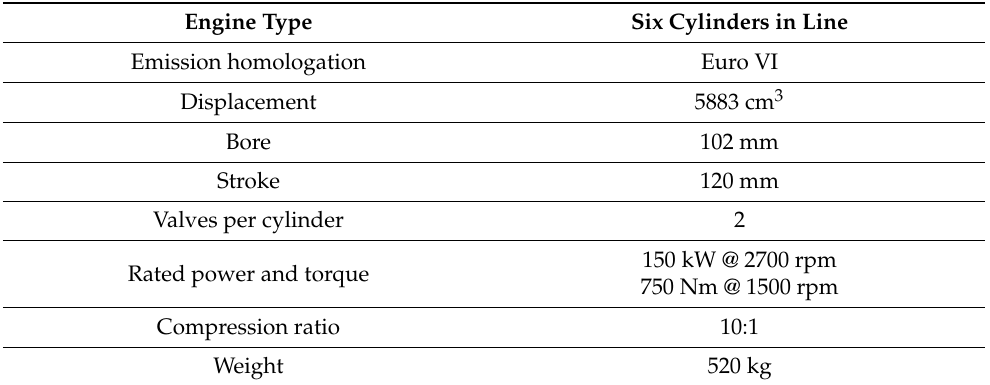
Table 2. Main characteristics of the EURO VI NG HD experimental